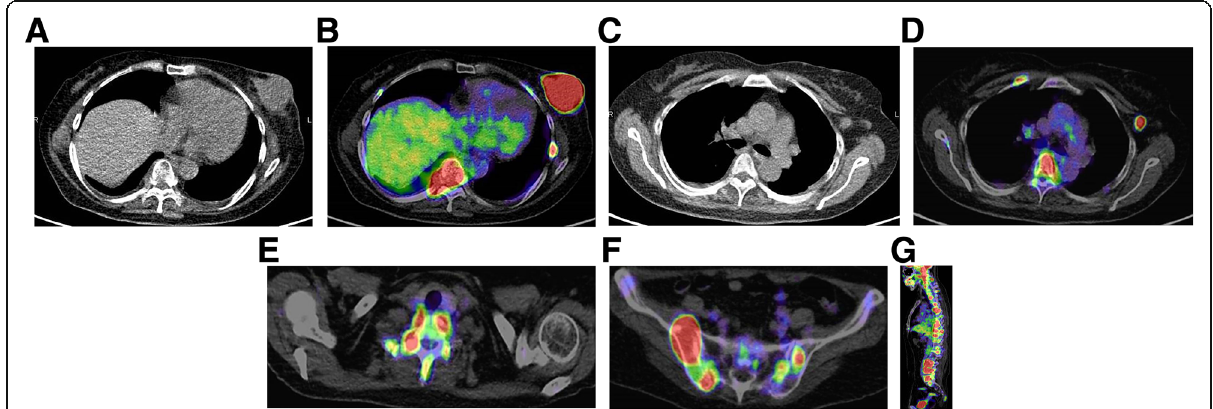
Fig. 6 A 58-year-old female patient presented with pathologically proven metastatic carcinoma left axillary lymph nodes. PET/CT revealed axial CT ( a ) and fused PET/CT ( b ) images showing avid FDG uptake metabolically active left breast lesion (SUVmax 12.8 suggested site of primary malignancy) with left axillary lymph node spread axial CT ( c ) and fused PET/CT ( d ) images. Axial ( e , f ) and sagittal ( g ) fused PET/CT images showing diffuse bone metastasis. Biopsy from the left breast lesion confirmed invasive ductal carcinoma (papillotubular type)